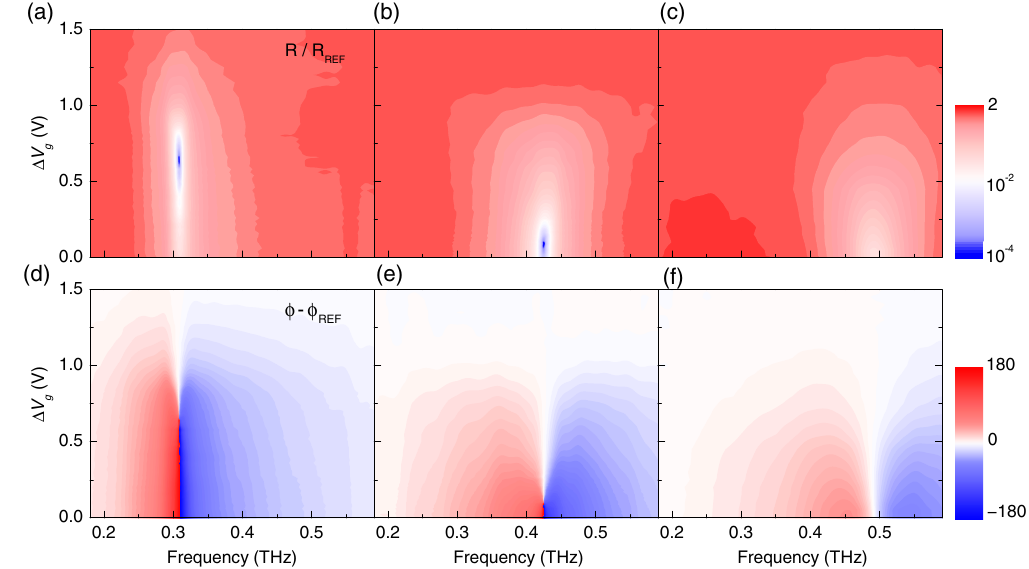
FIG. 4. Reflectance and phase modulation for metasurfaces with different spacer thicknesses. Reflectance modulations measured as a function of both gate voltage and frequency for devices with SU8 spacer thicknesses of (a) 85 μ m, (b) 60 μ m, and (c) 40 μ m. Data from these three devices are normalized to spectra measured at Δ V (d) – (f) Reflection phase modulations measured as a function of the gate voltage and frequency for the same three devices considered in (a) – (c). All three devices have a mesa size of 100 μ m × 160 μ m, and the mesa array has a period of 240 μ m in both the x and y directions. The incident THz wave is polarized along the long axis of the